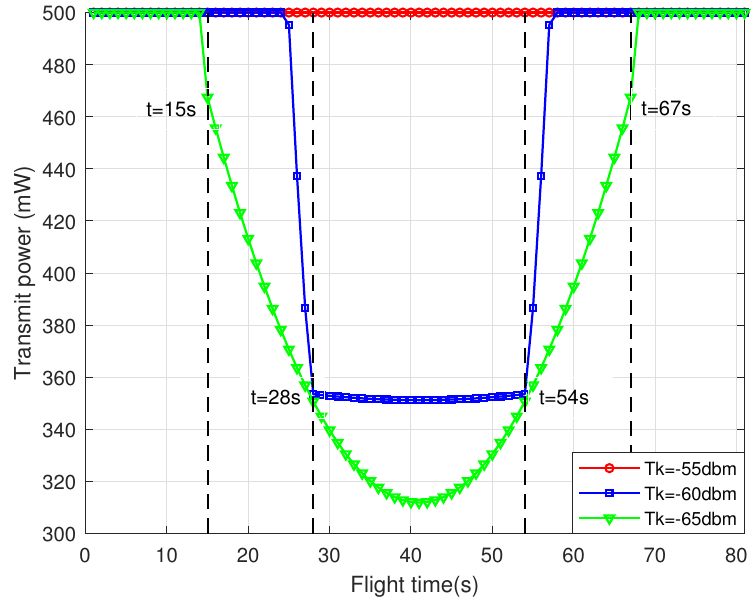
Figure 5. The transmit power versus time